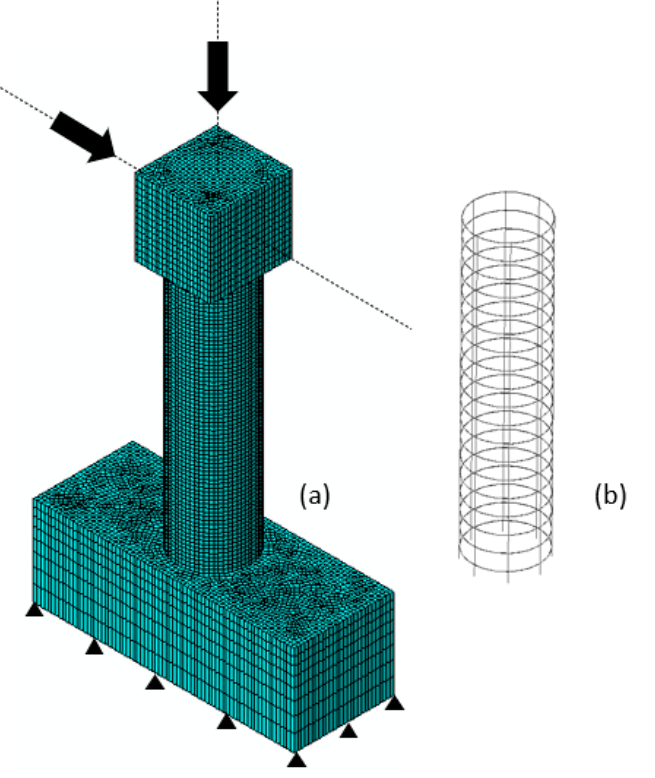
Figure 13. Finite element mesh of models ( a ) NSC and ( b ) reinforcement.